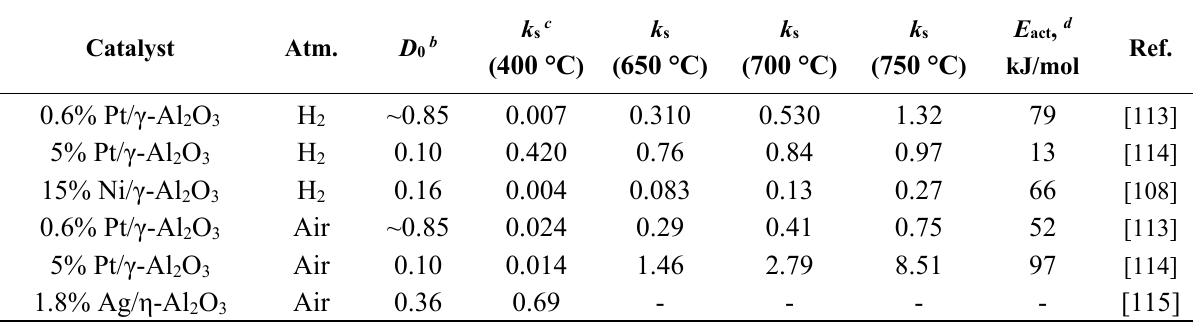
a Refs. [105,106]; b Initial metal dispersion or percentage exposed; c Second-order sintering rate constant from general power-law expression (GPLE) with units of h −1 ; d Sintering activation energy for